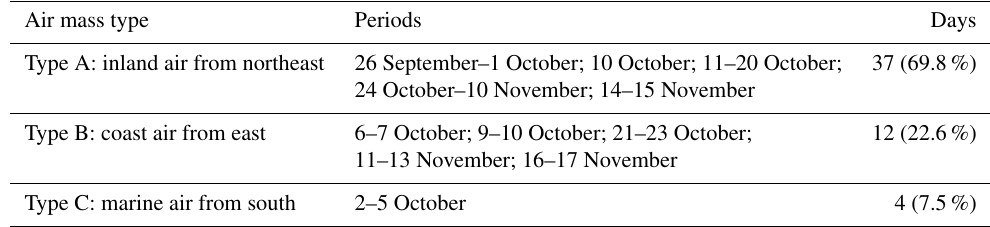
Figure 1. Time series of N 2 O 5 , ClNO 2 , and relevant parameters. The dotted grey line in the O 3 panel denotes Chinese national air quality standard for hourly maximum O 3 (200µgm − 3 , equivalent to 93ppbv). NO 3 radical is calculated based on a thermal equilibrium with measured NO 2 and N 2 O 5 . Table 2. The detailed information of three air mass